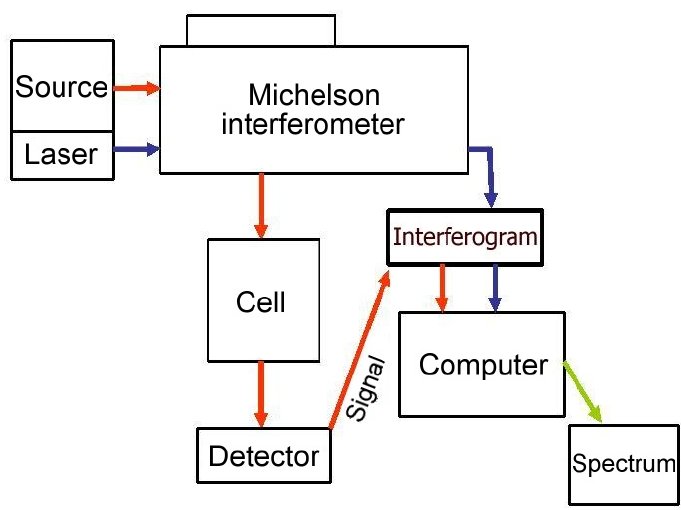
Figure 2. Inner arrangement of Bruker IFS 120 HR spectrometer [90].